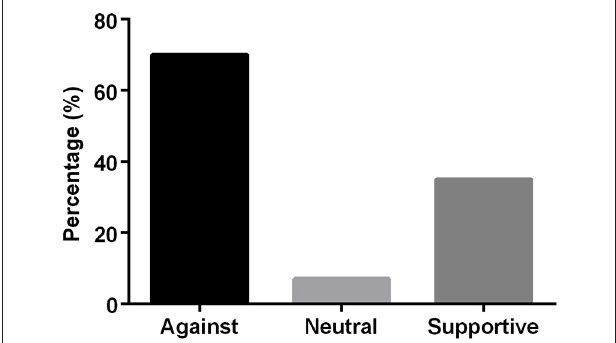
FIGURE 4 | Sources of information categorized based on varying reactions to the consumption of raw milk in the United States. The graph represents the percentage of messages that are against, neutral or in support of the consumption of raw milk.